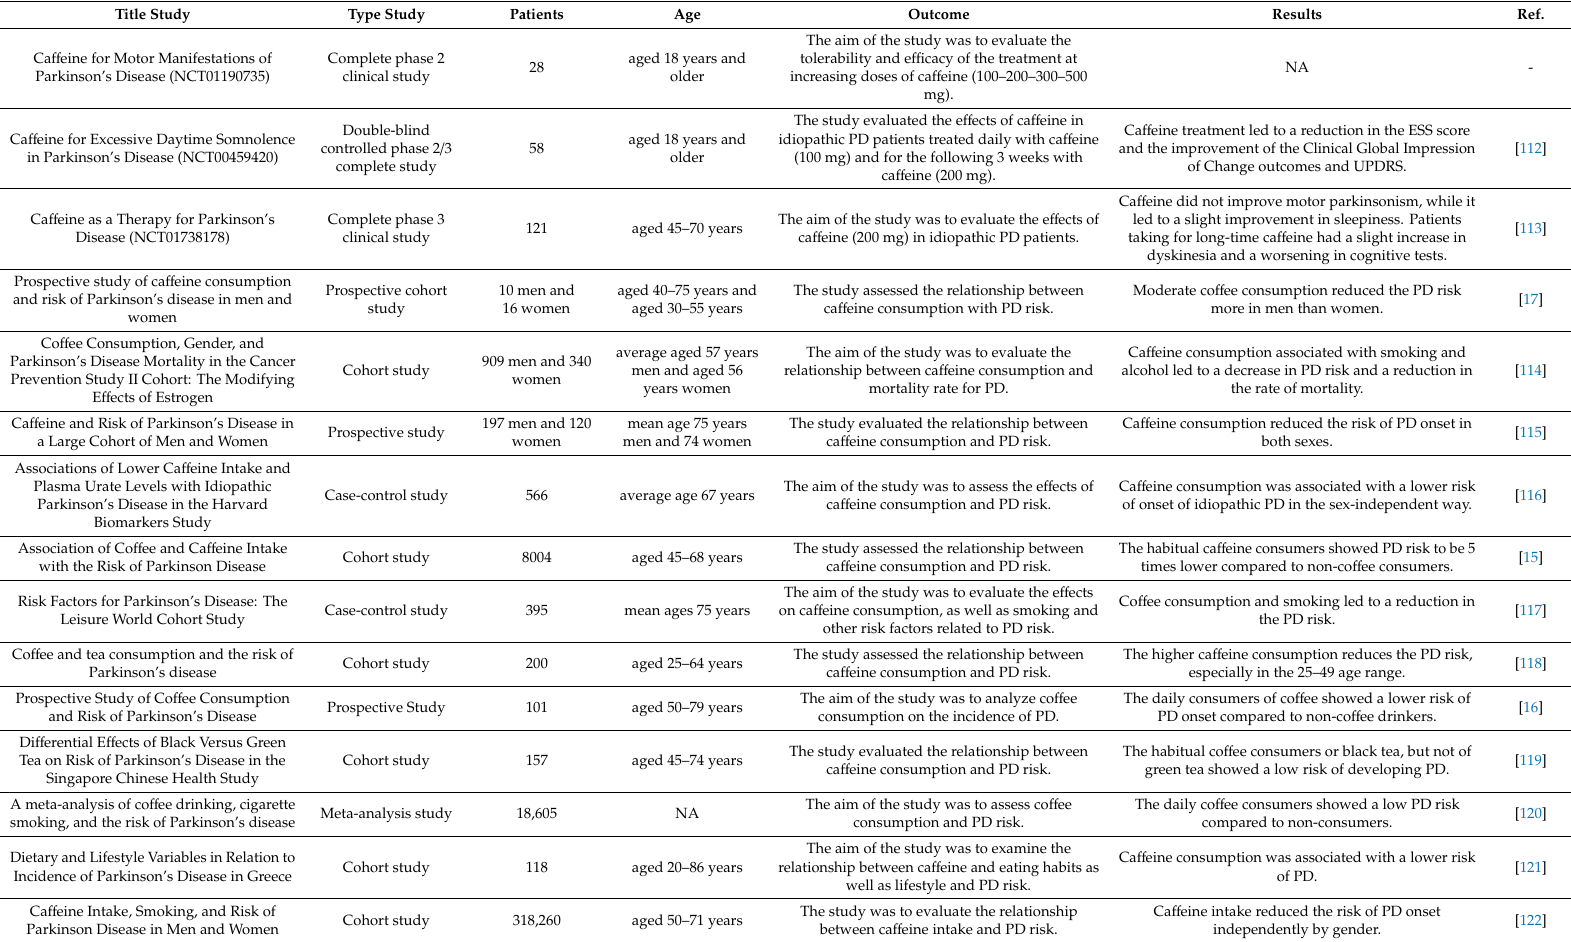
Table 2. Summary of the clinical studies that show the neuroprotective e ff ects of ca ff eine in PD patients and prospective studies that highlight the direct correlation between the consumption of ca ff eine and the low risk of